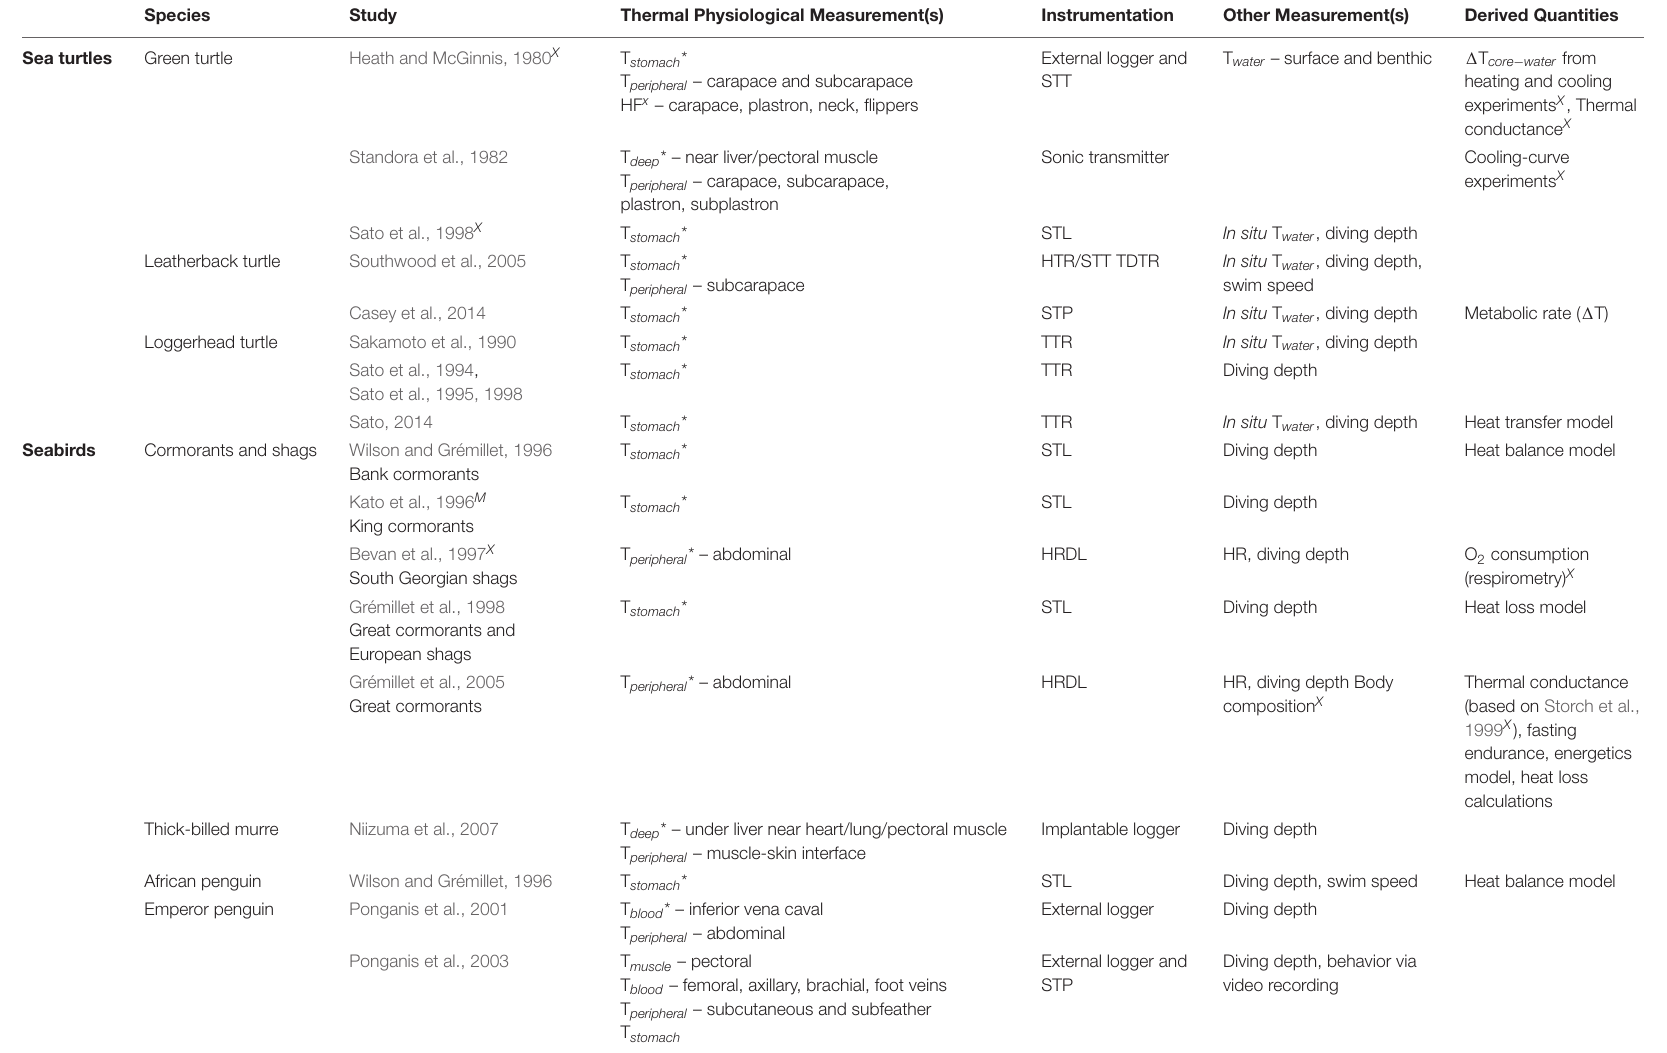
TABLE 1 | Summary of studies and their approaches used in field thermal physiological studies for (A) sea turtles, (B) seabirds, and (C) marine mammals. Species Study Thermal Physiological